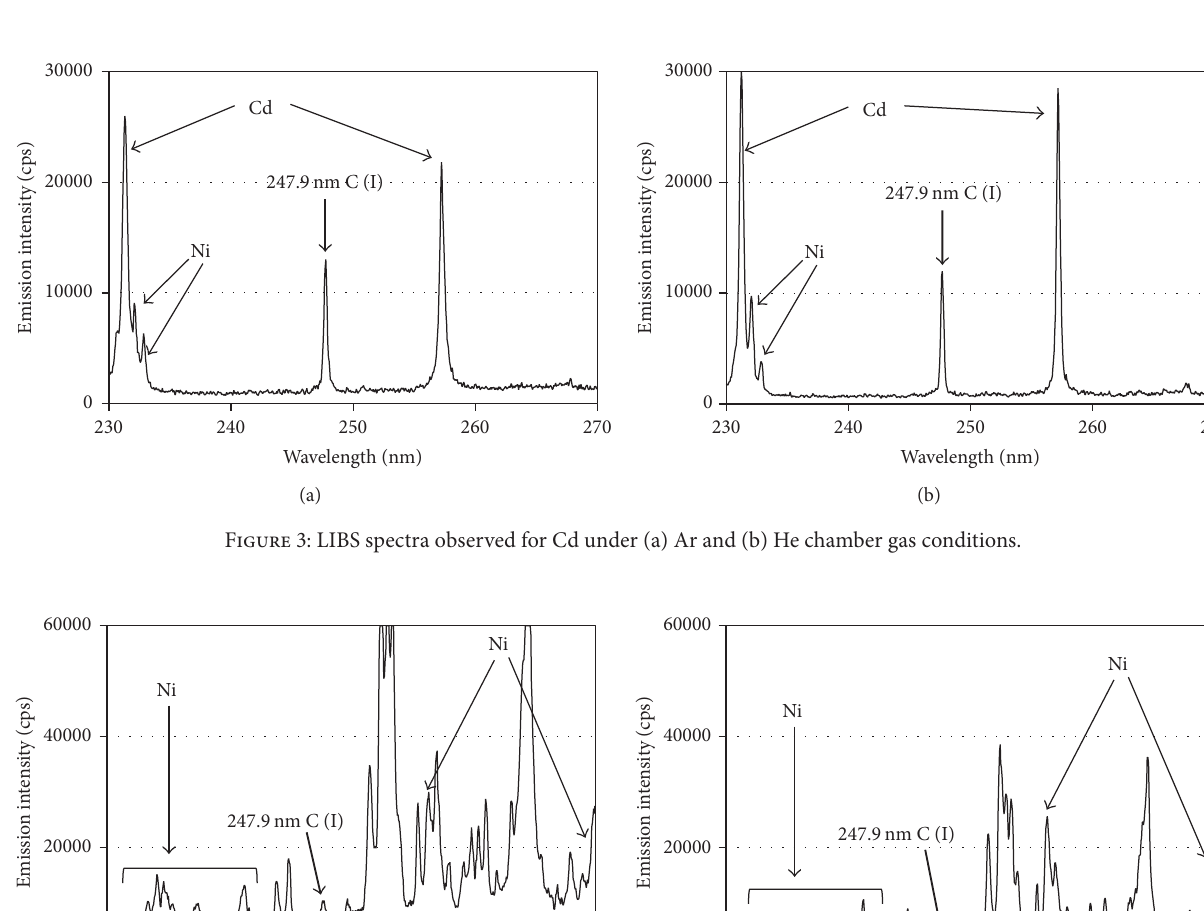
Figure 2: LIBS spectra observed for Zn under (a) Ar and (b) He chamber gas conditions.